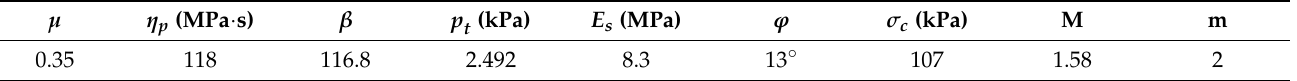
Table 5. Soil parameters of Group